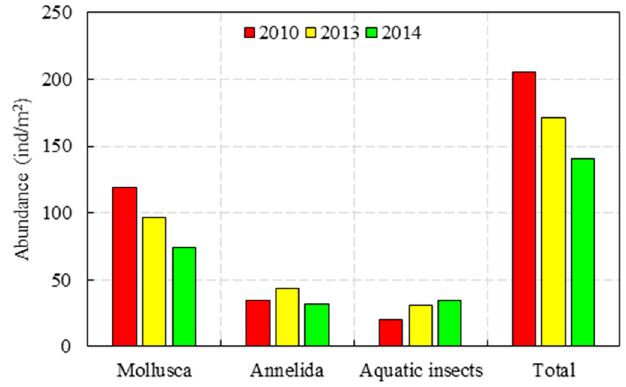
Figure 9. The abundance of Mollusca, Annelida, aquatic insects, and total benthic invertebrate at Lake Poyang in 2010, 2013, and 2014.